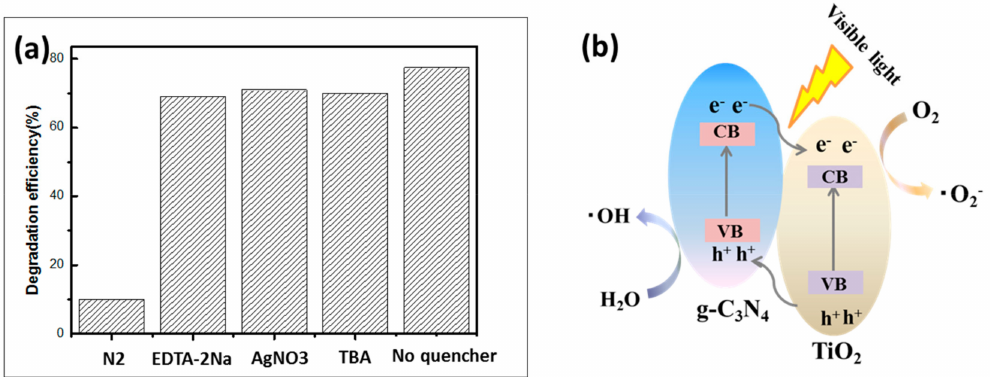
Figure 9. ( a ) Explore the e ff ects of photocatalytic e ffi ciency by adding di ff erent types of scavengers. ( b ) Schematic diagrams photocatalytic mechanism of the as-prepared TPCN composite under the visible light